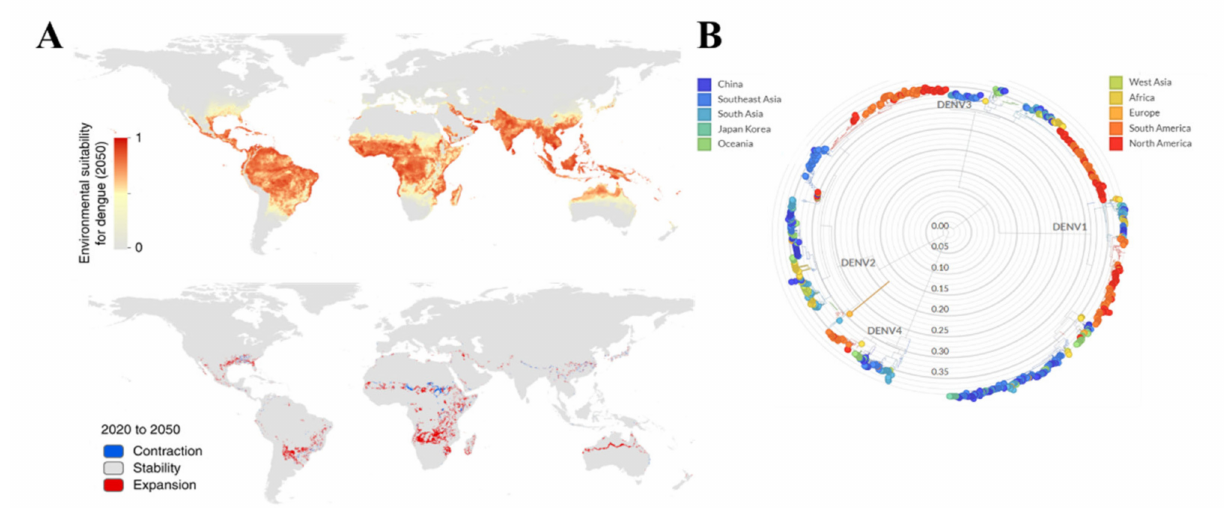
Figure 1. ( A ) Worldwide estimated distribution of dengue in next 30 years due to the climatic and population change [8]. ( B ) Phylogeny analysis of 922 complete genomes evolution of all DENV serotypes reported from January 2000 to